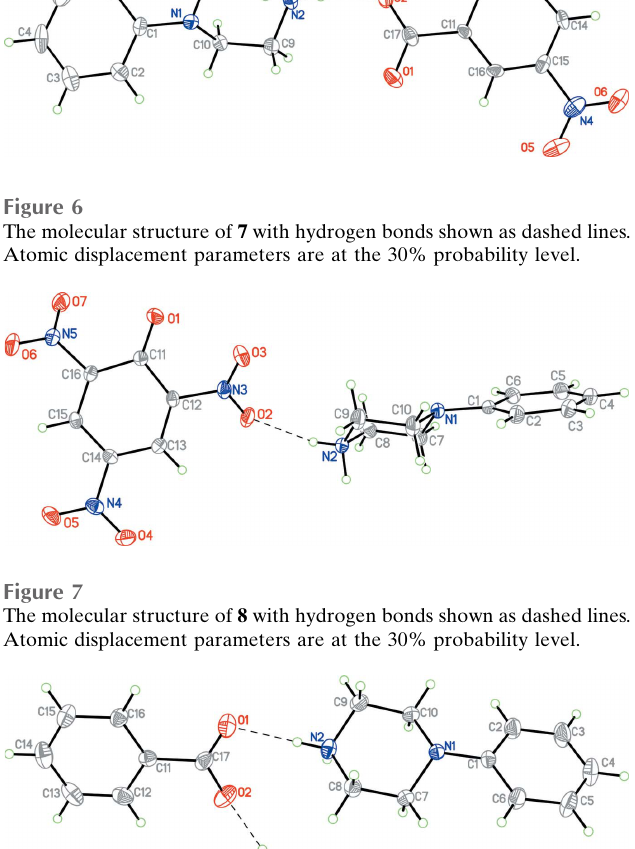
Figure 9 The molecular structure of 10 with hydrogen bonds shown as dashed lines and disorder of the phenyl rings indicated. Atomic displacement parameters are at the 30% probability level.